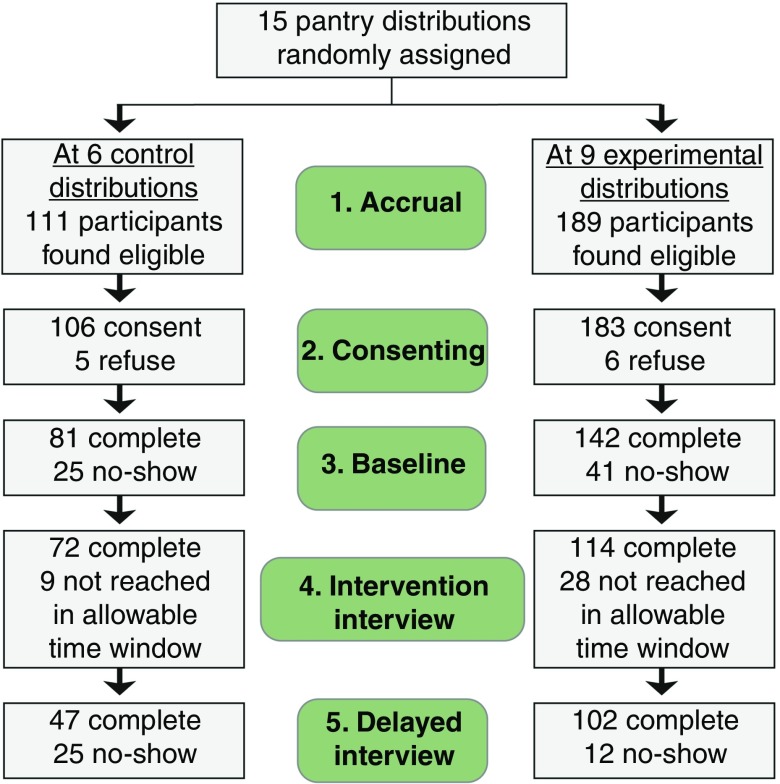
(colour online) CONSORT (Consolidated Standards of Reporting Trials) flow diagram showing the numbers of households retained at five steps of data collection